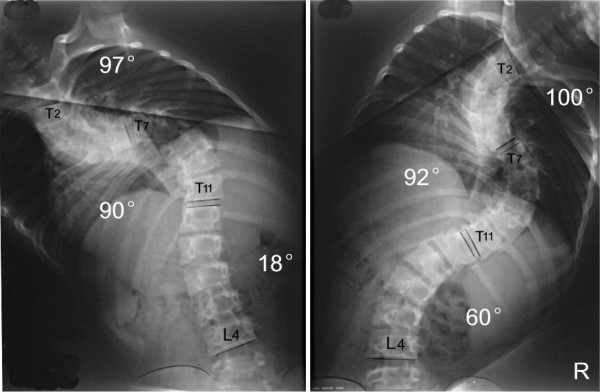
Bending view shows the change of deformity.